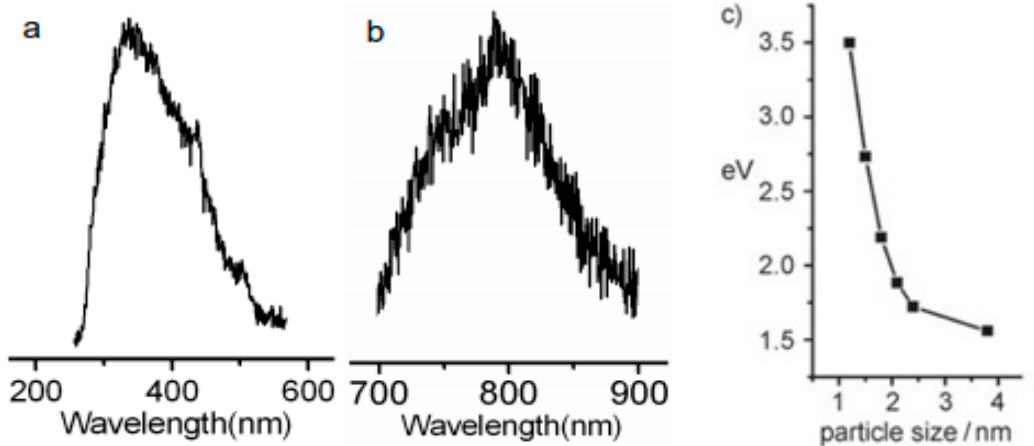
Figure 5. PL spectra of ( a ) small-sized C-dots (1.2 nm) and ( b ) large-sized C-dots (3.8 nm). ( c ) Size dependence of the bandgap in C-dots. Reprinted (adapted) with permission from [51]. Copyright 2021 John Wiley and Sons.